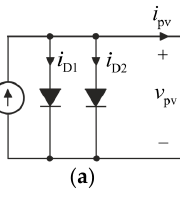
Figure 2. Equivalent circuits of a solar cell: ( a ) ideal two-diode model; and ( b ) practical single-diode model.